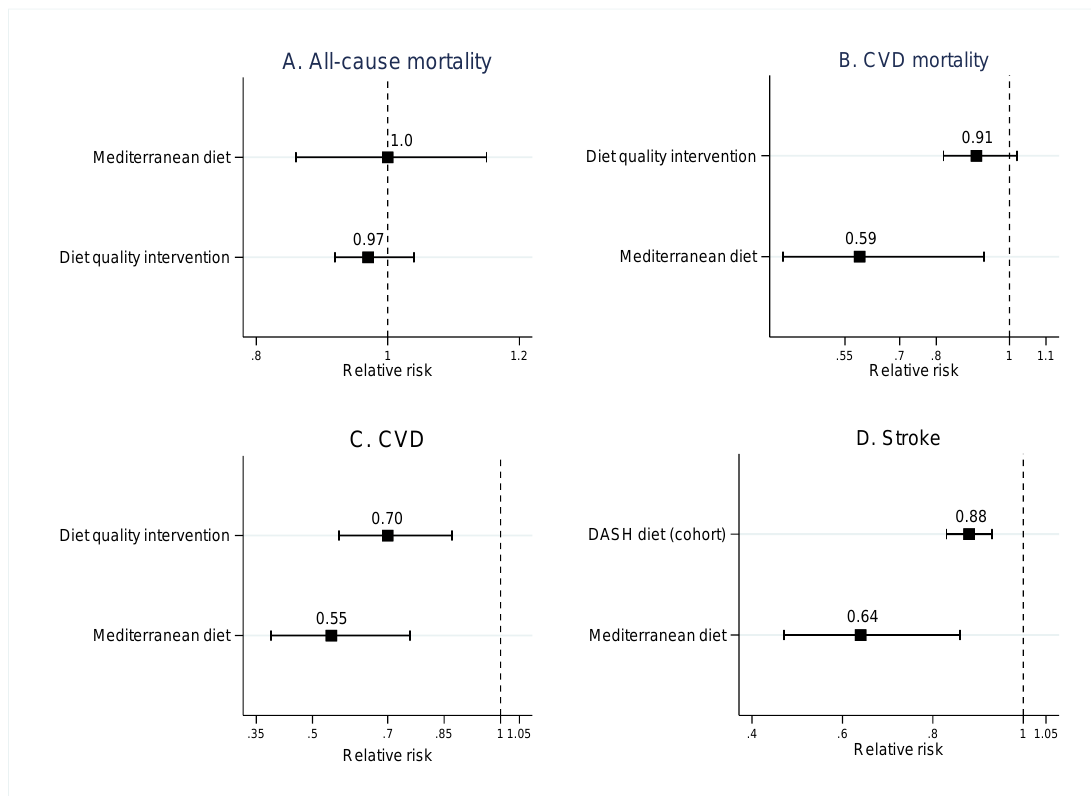
Figure 2. Pooled risk ratios of dietary patterns and the risk of all-cause ( A ) and cardiovascular mortality ( B ), cardiovascular disease ( C ), and stroke ( D ). Results are from systematic reviews and meta-analyses of randomized controlled trials, except for that of the Dietary Approaches to Stop Hypertension (DASH) diet, which is from observational studies. (CVD, cardiovascular diseases)